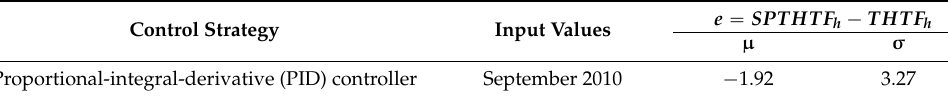
Table 3. Numerical results of simulation with PID (September 2010).